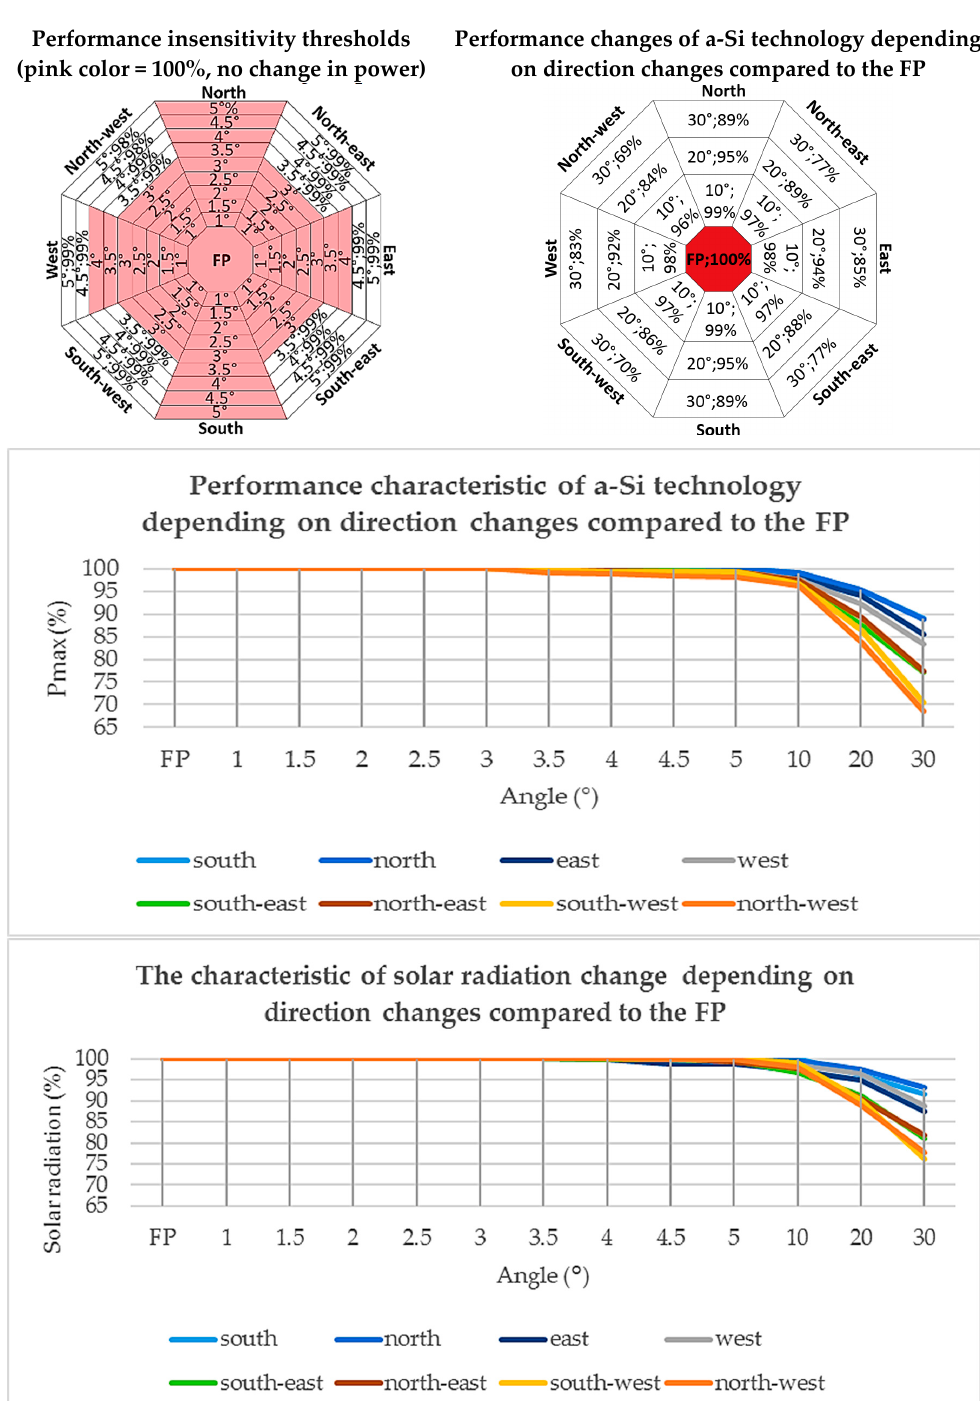
Figure 10. The performance insensitivity thresholds, the performance changes, the solar radiation features and the performance characteristics of a-Si technology depending on directional changes compared to the FP.